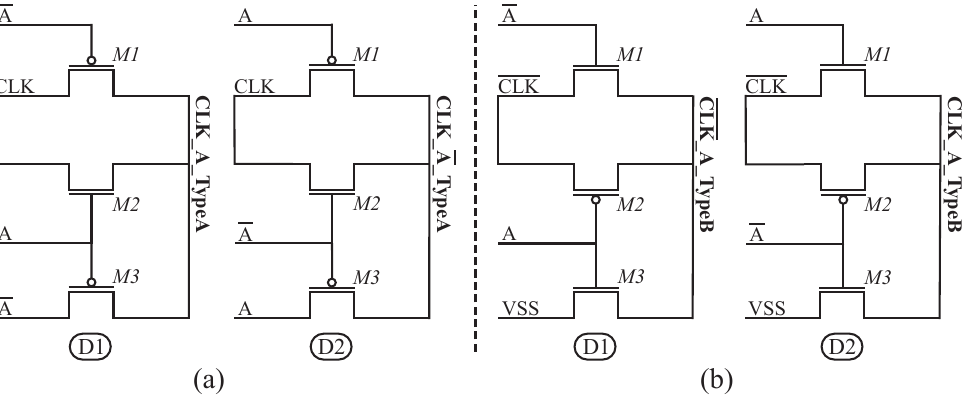
Figure 4. Controller schematics using Pass Transistor Logic: ( a ) Controller for Type-A stages. ( b ) Con- troller for Type-B stages.